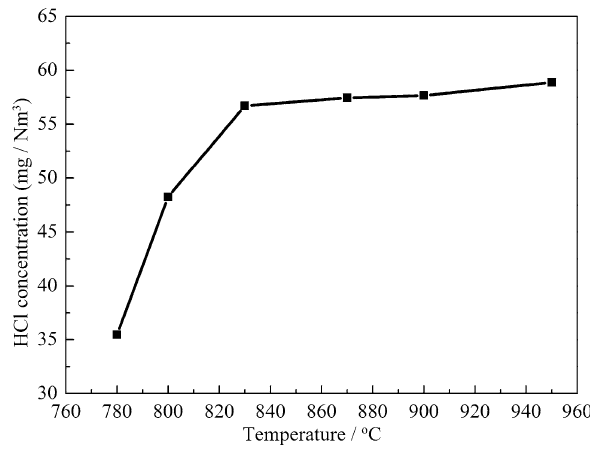
Fig. 4 Effect of bed temperature on the HCl emission